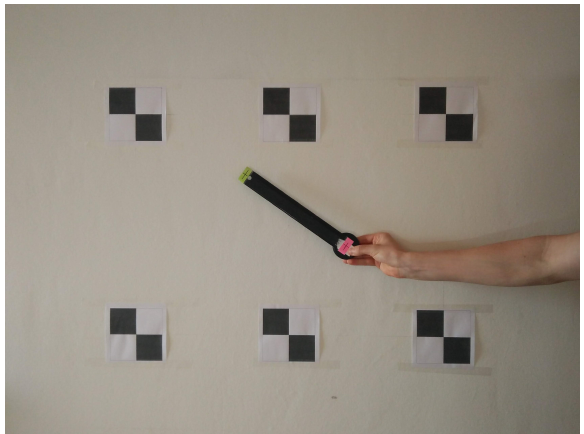
Figure 10. Method for sensor validation based on photogrammetry using convenient, commercial off-the-shelf equipment. By comparing the data from the IMU with the data extracted from images, the static error on the measurements can be derived for the pitch and roll axis.